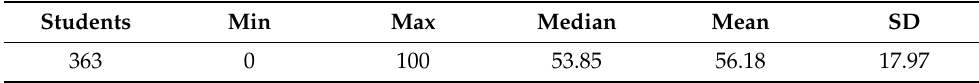
Table 5. Overall success rate—descriptive